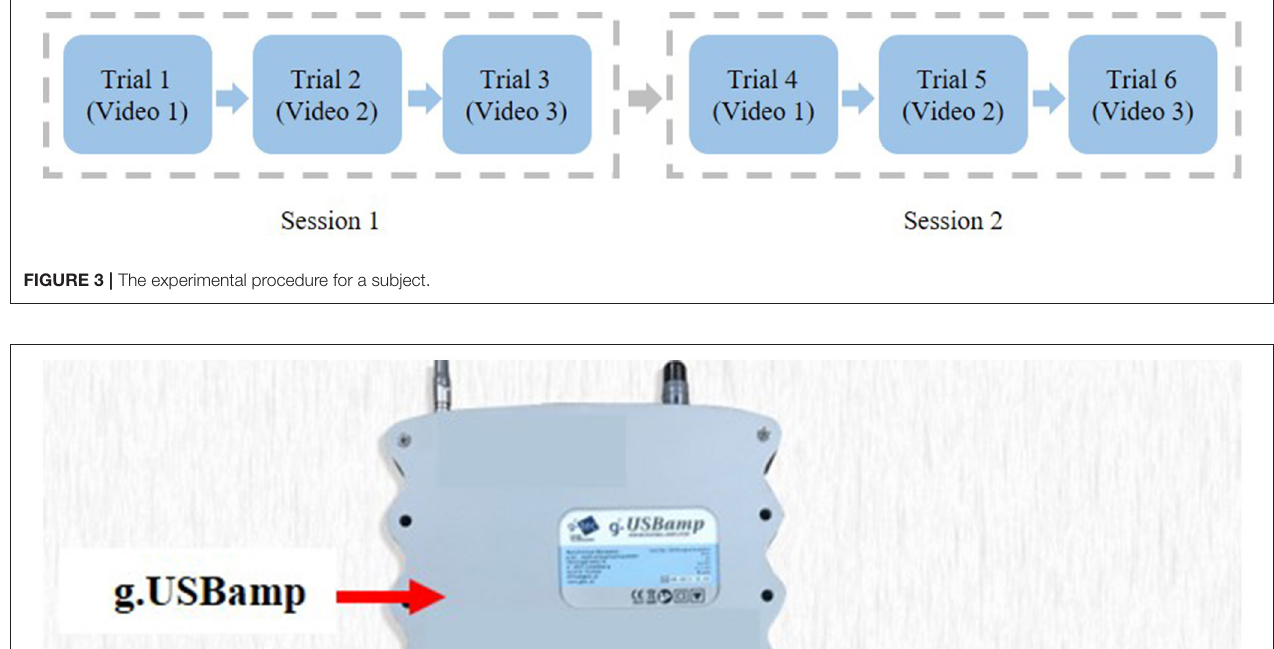
FT8, T7, T8, C5, C6, TP7, TP8, CP5, CP6, P7, P8) were used and their positions are shown in Figure 5